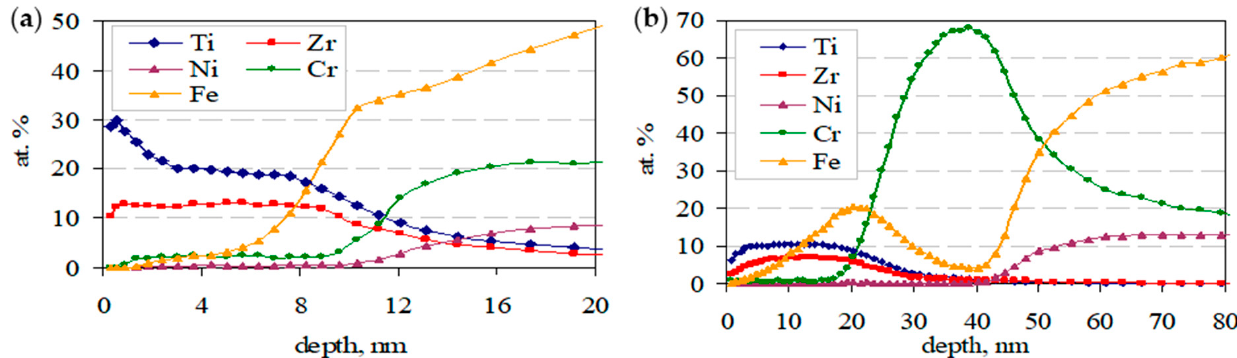
Figure 3. Quantitative depth profile analysis of single layer sol–gel TiO 2 –ZrO 2 films on stainless steel obtained by GD-OES: ( a ) annealed at 400 °C; ( b ) annealed at 600 °C.